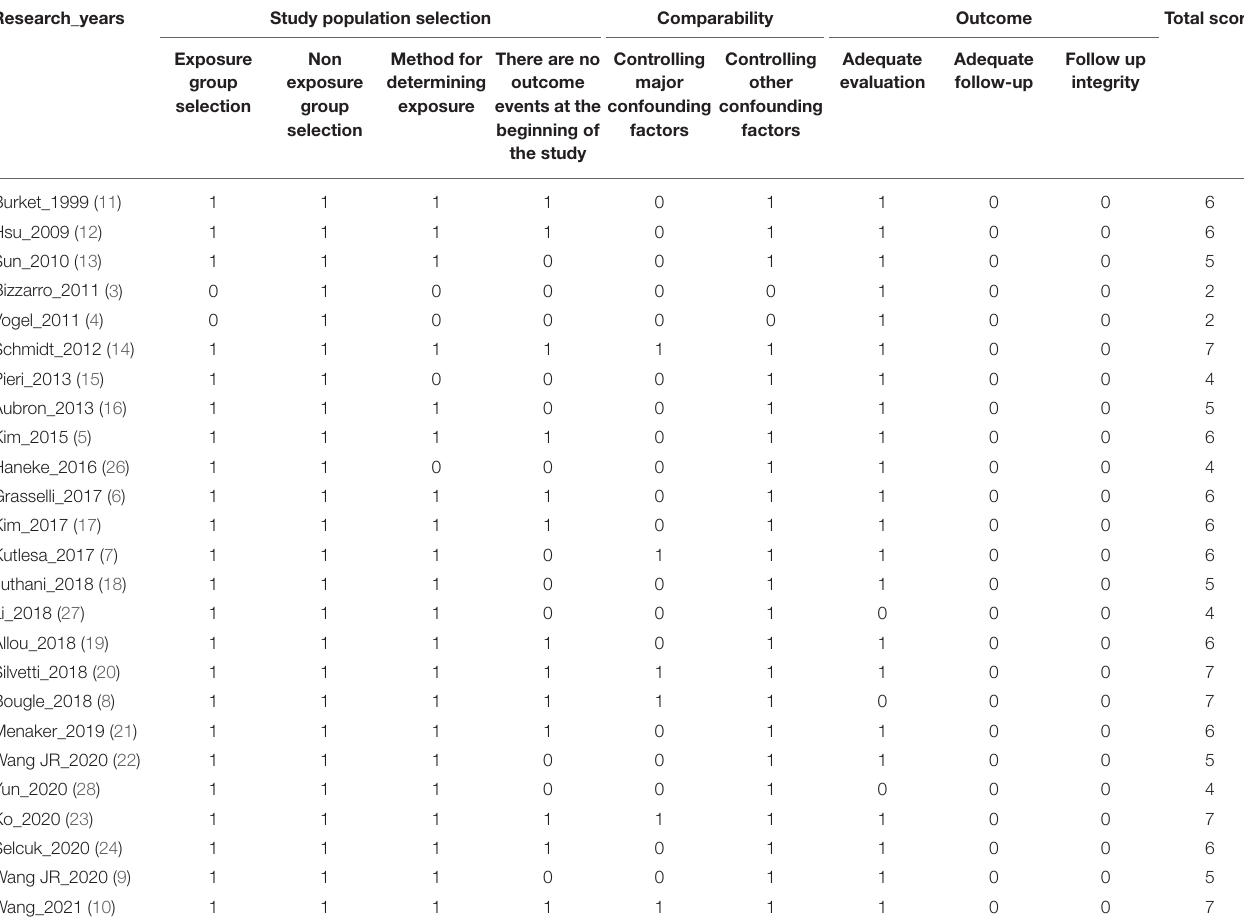
TABLE 1 | Newcastle–Ottawa Scale (NOS) evaluation of the included